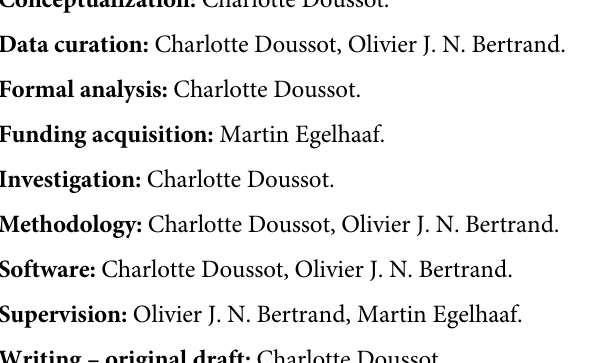
S5 Fig. The set of views S for the B4-model taken at 5cm from nest hole. The 4 views repre- sented as an equirectangular projection is overlaid with the corresponding rotIDF function with the current view as in Fig